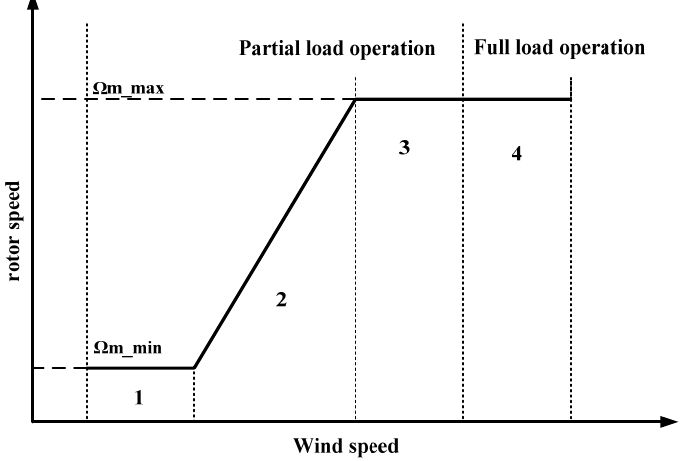
Figure 2. Wind turbine operation zones.